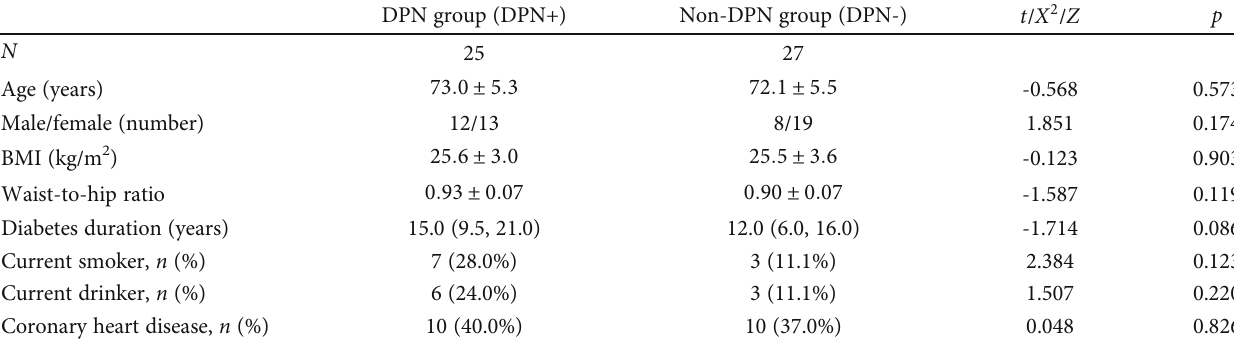
Table 1: Characteristics of the DPN group (DPN+) and the non-DPN group